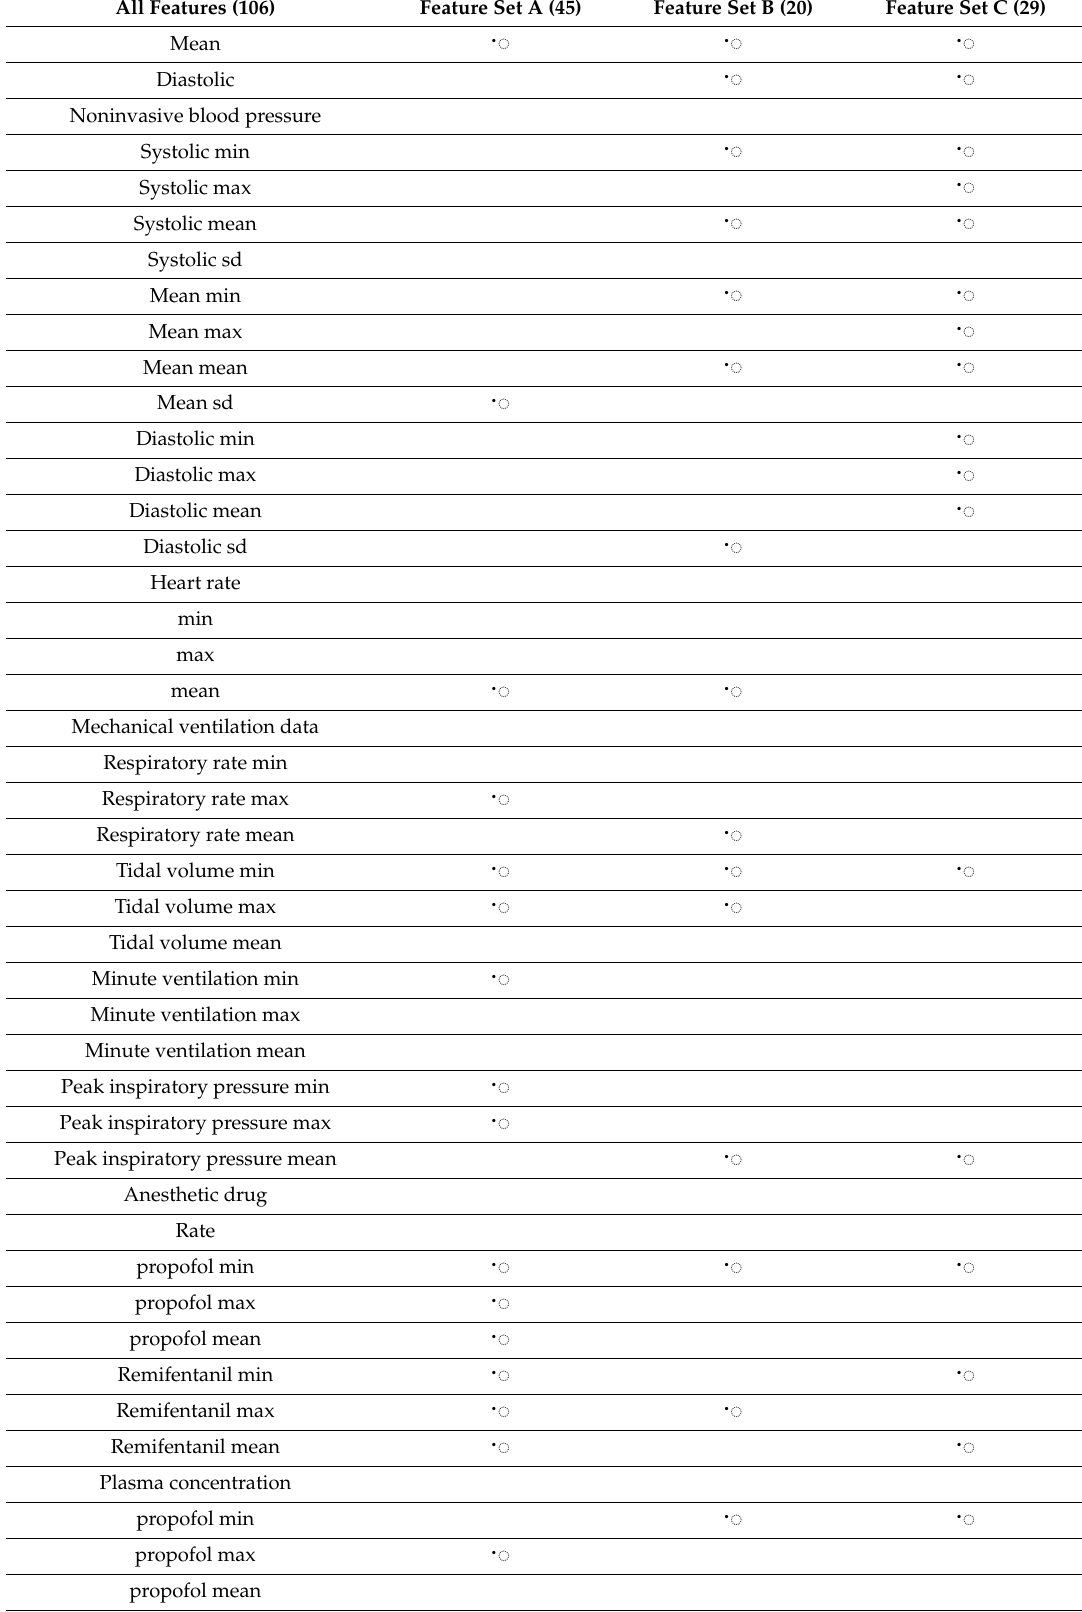
Table A1. Feature sets from feature selection. All features (106)